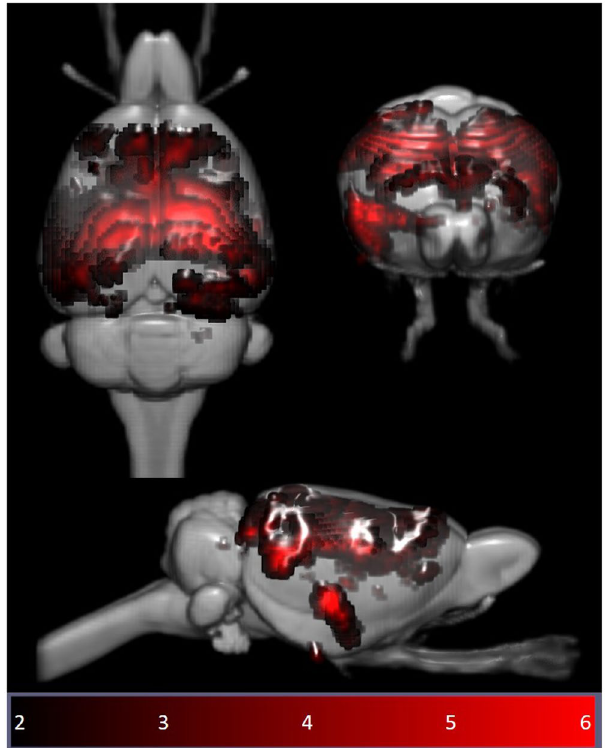
Figure 2. Independent component maps of pre-stimulation rs-fMRI group overlaid on 3D-rendered standard Sprague Dawley brain atlas. The figure shows the superior view (top left), anterior view (top right) and lateral view (bottom) of the chosen six non-artefactual independent components from the group-ICA. The spatial colour-coded z-maps of these components are overlaid on the brain atlas (down-sampled by a factor of eight). A higher z-score (bright red) represents a higher correlation between the time course of that voxel and the mean time course of the components. Colour bar indicates z-scores (n = 24, thresholded at z > 2, uncorrected p-value < 0.0455 for a two-tailed